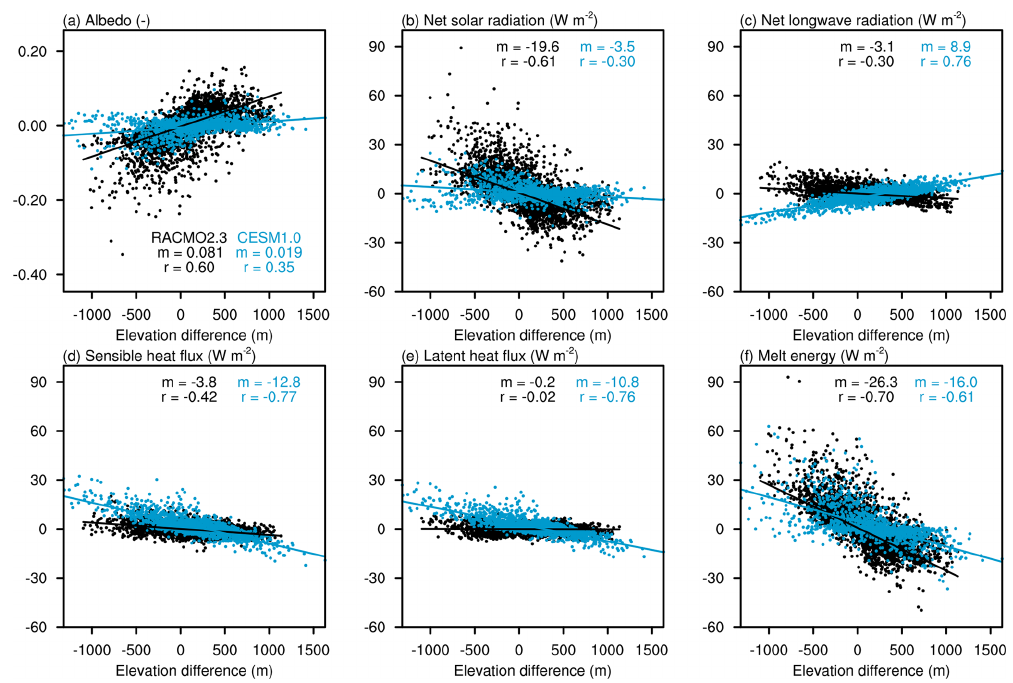
Figure 1. Comparison of EC downscaling (simulation EC-6K, blue) versus dynamical downscaling in a RCM (RACMO2.3, black) for several summer (JJA) SEB components and near-surface climate, (a) albedo, (b) net solar radiation (Wm − 2 ), (c) net longwave radiation (Wm − 2 ), (d) sensible heat flux (Wm − 2 ), (e) latent heat flux (Wm − 2 ), and (f) melt energy (Wm − 2 ). The x values show the deviation of surface elevation ( m ) from the coarse grid cell ( ∼ 100km) mean, and the y values show the deviation of the physical quantity from the grid cell mean. In plots (b) through (f) , positive y values indicate more energy available for melting. Melt energy (f) is the sum of the radiation and turbulent flux terms in (b) through (e) plus the ground heat flux (not shown). The lines represent least-squares linear regression. The annotated m is the least-squares linear regression gradient (Wm − 2 km − 1 or km − 1 for albedo); r is the correlation